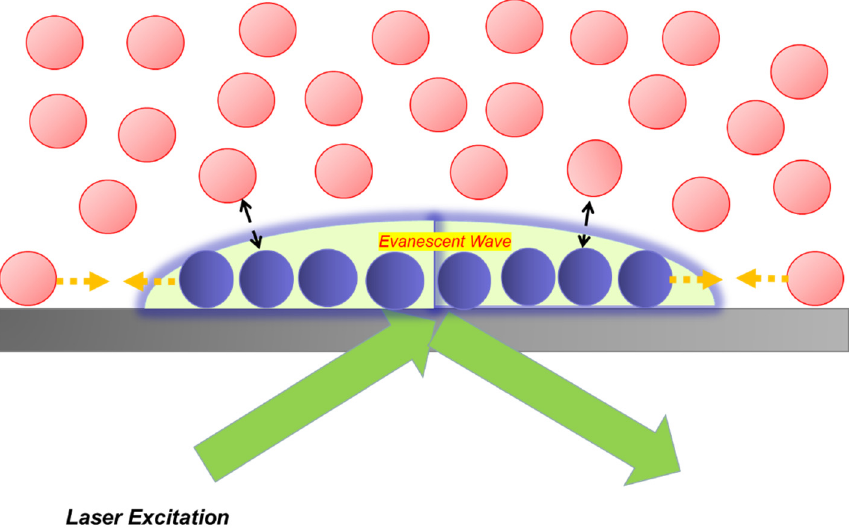
Figure 5. Total internal reflection (TIR) microscopy taps on the production of an evanescent wave, which specifically illuminates biomacromolecules (circles) close to the solid substrate (e.g., fused silica). Immediately after photobleaching, the fluorescent tag on the biomacromolecules were deac- tivated by the intense laser beam (purple circles) and lost the fluorescence signal to be detected by CCD camera or photomultiplier tube. Afterwards, the fluorescence signal recovers by the exchange of the bleached molecules inside the region of interest with those unbleached biomacromolecules (red circles) through adsorption/desorption kinetics and surface diffusion.